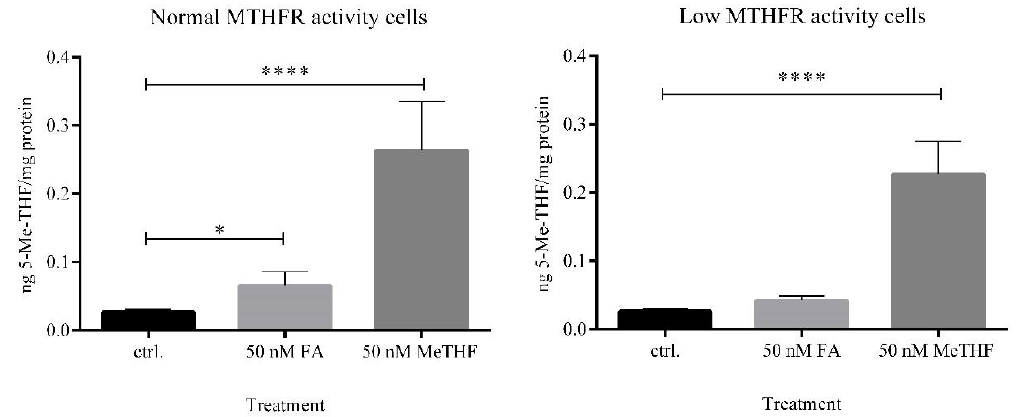
Figure 5. Intracellular 5-methyltetrahydrofolate concentrations. LCLs were treated with equimolar concentration of folate supplements, FA and 5-Me-THF, for 72 h. The concentration of 5-Me-THF was measured in cell lysates with LC-MS/MS. Cells with a defective reduced folate carrier were excluded from the analysis. Statistical differences were determined by one-way ANOVA with a post hoc Tukey’s multiple comparisons test. Values are means ± SD. * p ≤ 0.05, **** p ≤ 0.0001, compared to untreated control (ctrl.).